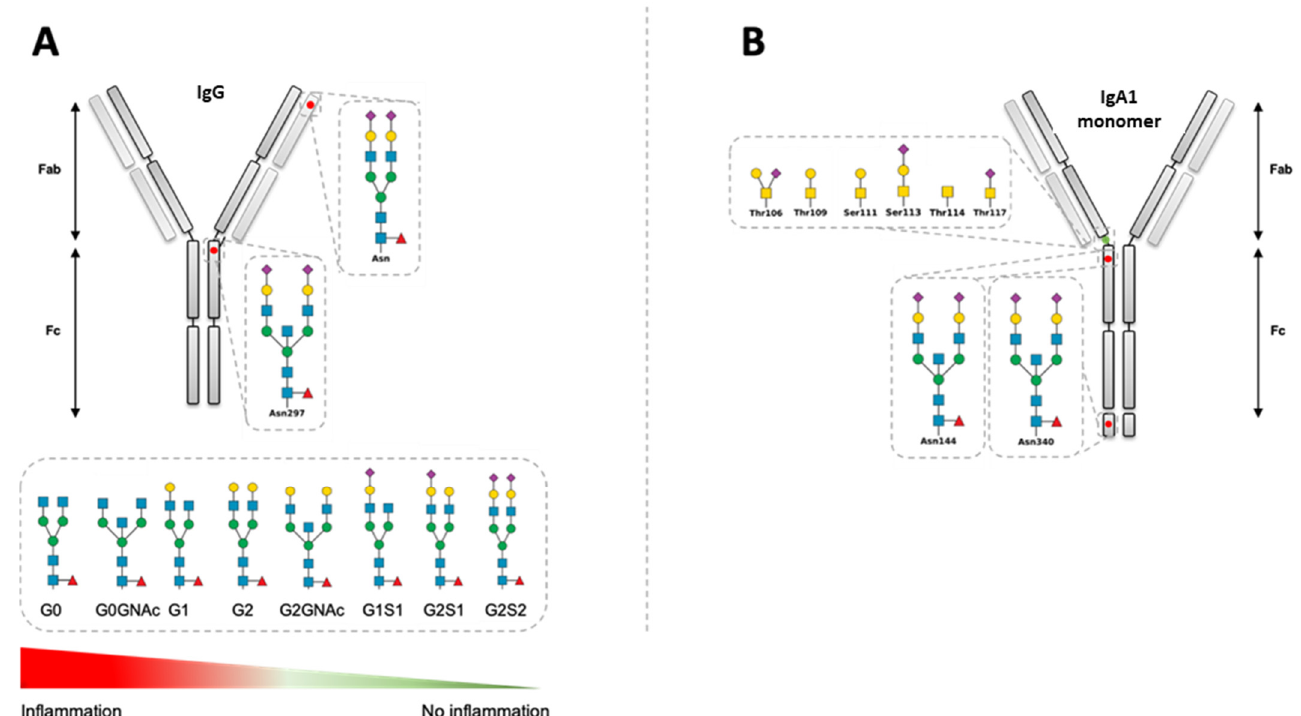
Figure 3. ( A ) IgG glycosylation. ( B ) IgA1 glycosylation. In addition, IgA2 contains two N -glycosylation sites, at Asn47 and Asn205. Red triangle for fucose (Fuc); yellow circle for galactose 5Gal); blue circle for glucose (Glc); yellow square for N -acetylgalactosamine (GalNAc); blue square for N -acetylglucosamine (GlcNAc); purple square for N -acetylneuraminic acid (Neu5Ac). Asn: asparagine; Ser/Thr: serine/threonine.